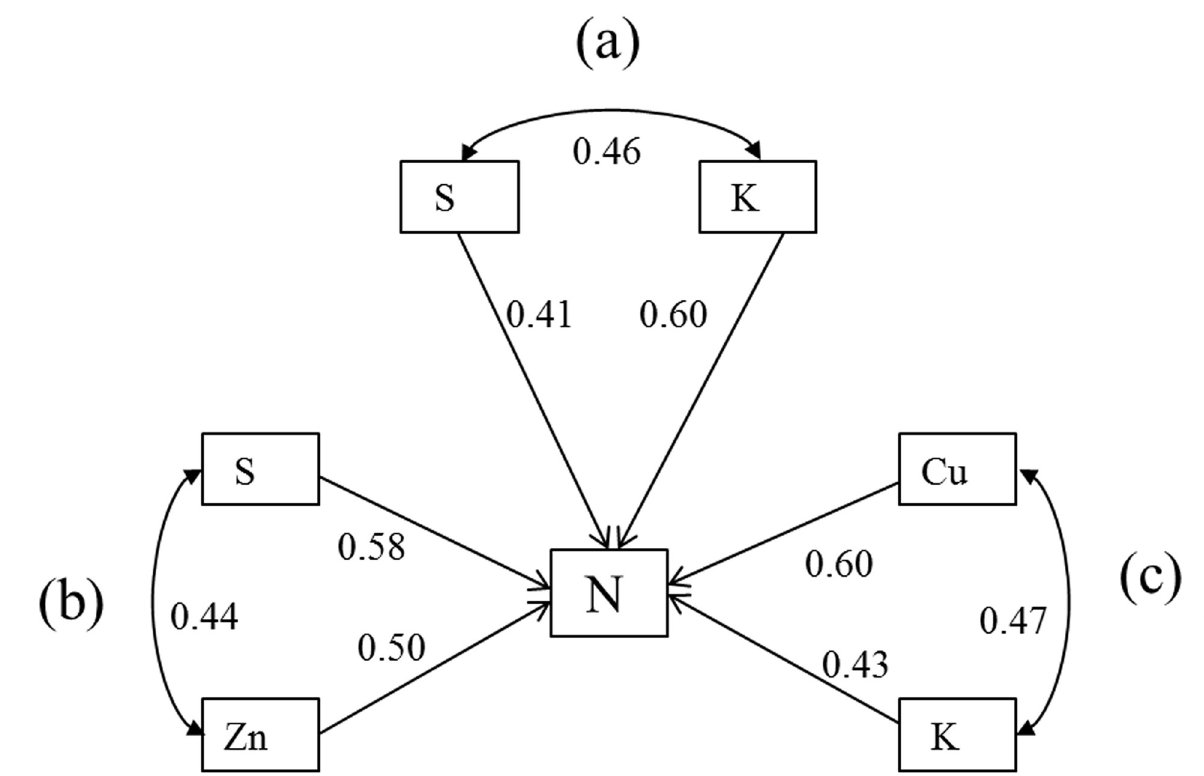
Fig 2. Path analysis results showing the relationships between the nutrient elements and the limiting element (N). (Note: (a) K, S, N path analysis for sites with 40%~10% coverage; (b) S, Zn, N path analysis for sites with 100%-70% coverage; (c) Cu, K, N path analysis for sites with 70%-40%